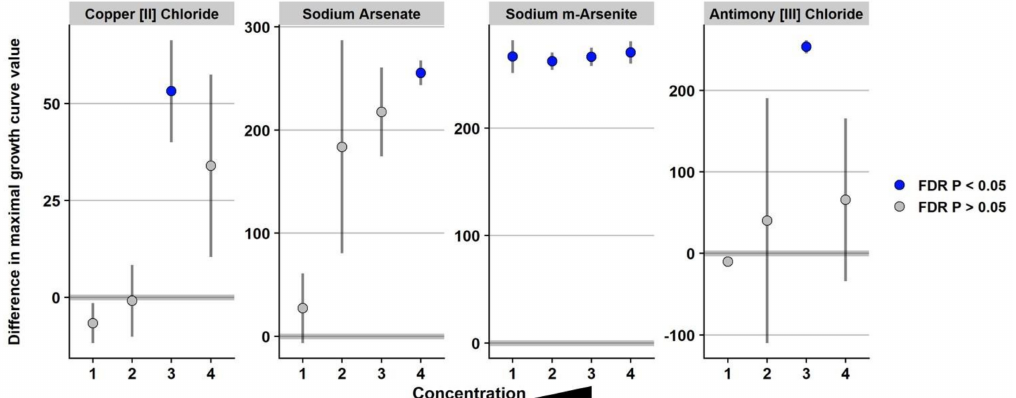
Figure 1. Significantly enhanced metal tolerance in Salmonella strains containing Salmonella Genomic Island 4. Analysis of Salmonella strains grown in Biolog Phenotype Microarrays identified significantly enhanced growth in copper chloride, sodium arsenate, sodium m-arsenite, and antimony chloride for strains USDA15WA-1 and BBS 1359 containing SGI-4 compared to strains BSX 120 and BBS 1270 lacking SGI-4. Strains were grown in 4 increasing concentrations of the chemical compounds in individual wells. Bacterial growth in wells with data points shown in blue is statistically significant ( p <